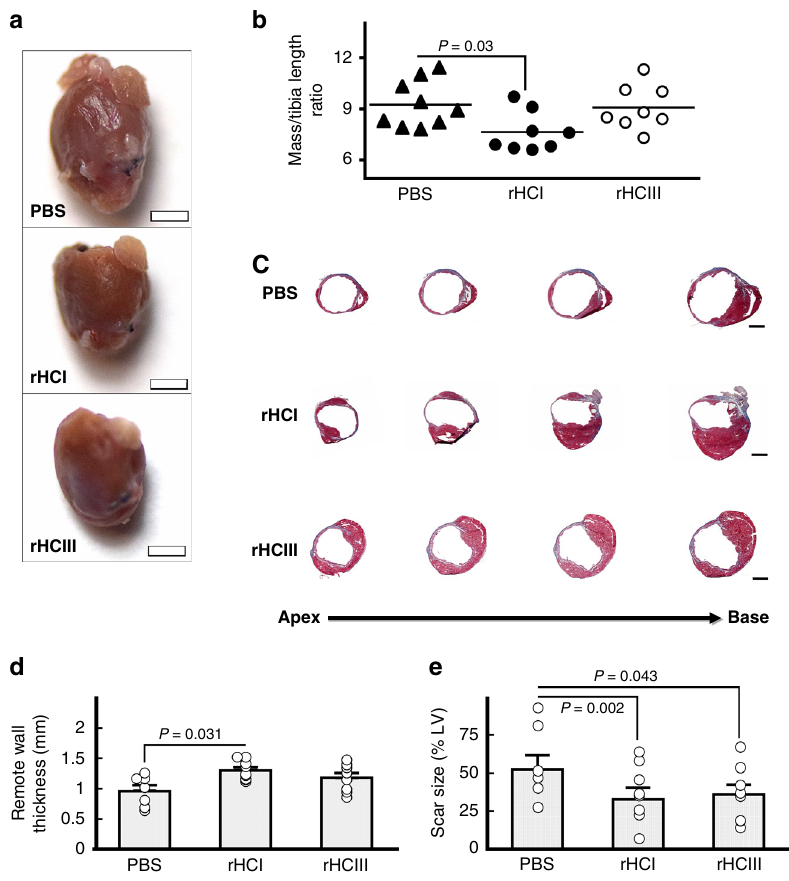
Fig. 3 Morphology of MI hearts is improved by rHCI treatment. a Representative images of hearts harvested 28 days after treatment (bar = 2 mm). b Scatter plot for the heart mass/tibia length ratio measured 28 days post injection ( n = 8 – 9). P- values were determined by a one-way ANOVA followed by Holm ’ s multiple comparisons to PBS control. c Representative Masson ’ s trichrome-stained sections of hearts harvested at 28 days (bar = 1 mm). d Wall thickness of the remote myocardium measured in Masson ’ s trichrome-stained tissue sections at 28 days post treatment ( n = 7 – 8). P -values were determined by one-way ANOVA using Holm ’ s multiple comparison. e Scar size (% of LV) measured at 28 days post treatment in Masson ’ s trichrome- stained tissue sections ( n = 7 – 8). P -values were determined by multiple regression analysis, including treatment group (rHCI, rHCIII and PBS) and baseline LVEF. rHCI and rHCIII as compared with PBS were signi fi cant predictors of infarct size, in addition to baseline LVEF. The correlation coef fi cient for the model is 0.6. The data are presented as the mean ± SEM. Source data are provided as a Source Data fi le. For a – e , n indicates the number of mice per